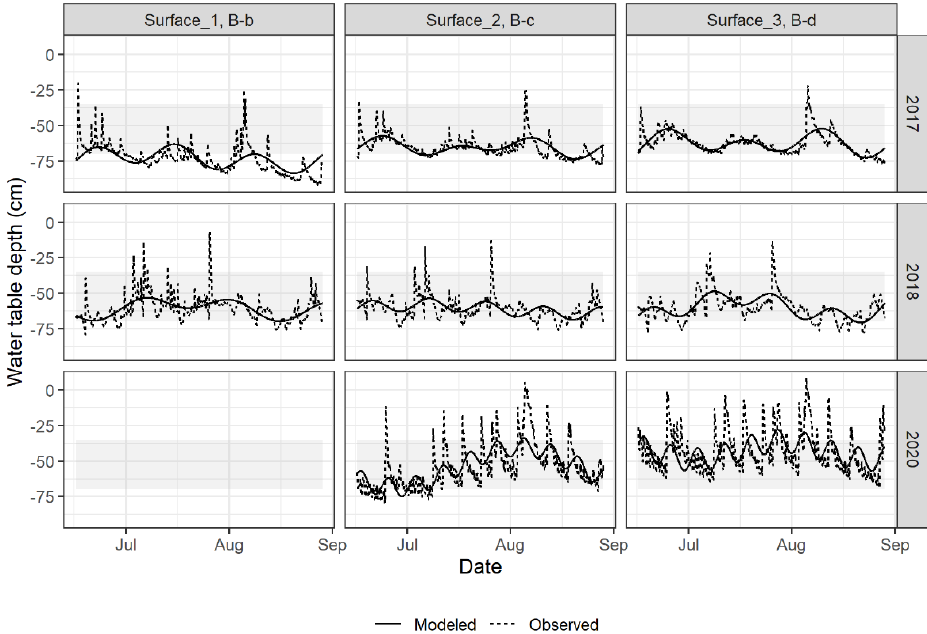
Figure 4. Observed and modelled time series of WTDs using multi-frequential periodogram for the Surface sites and years meeting the required water management conditions.